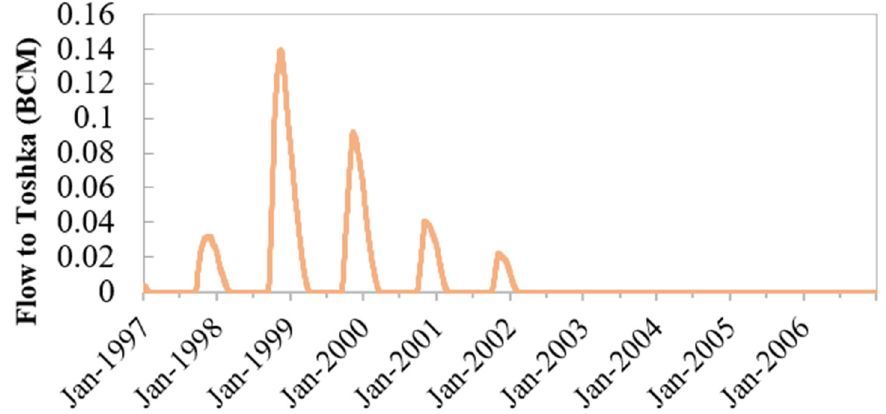
Figure 11. Toshka Spillway flow in simulation model.